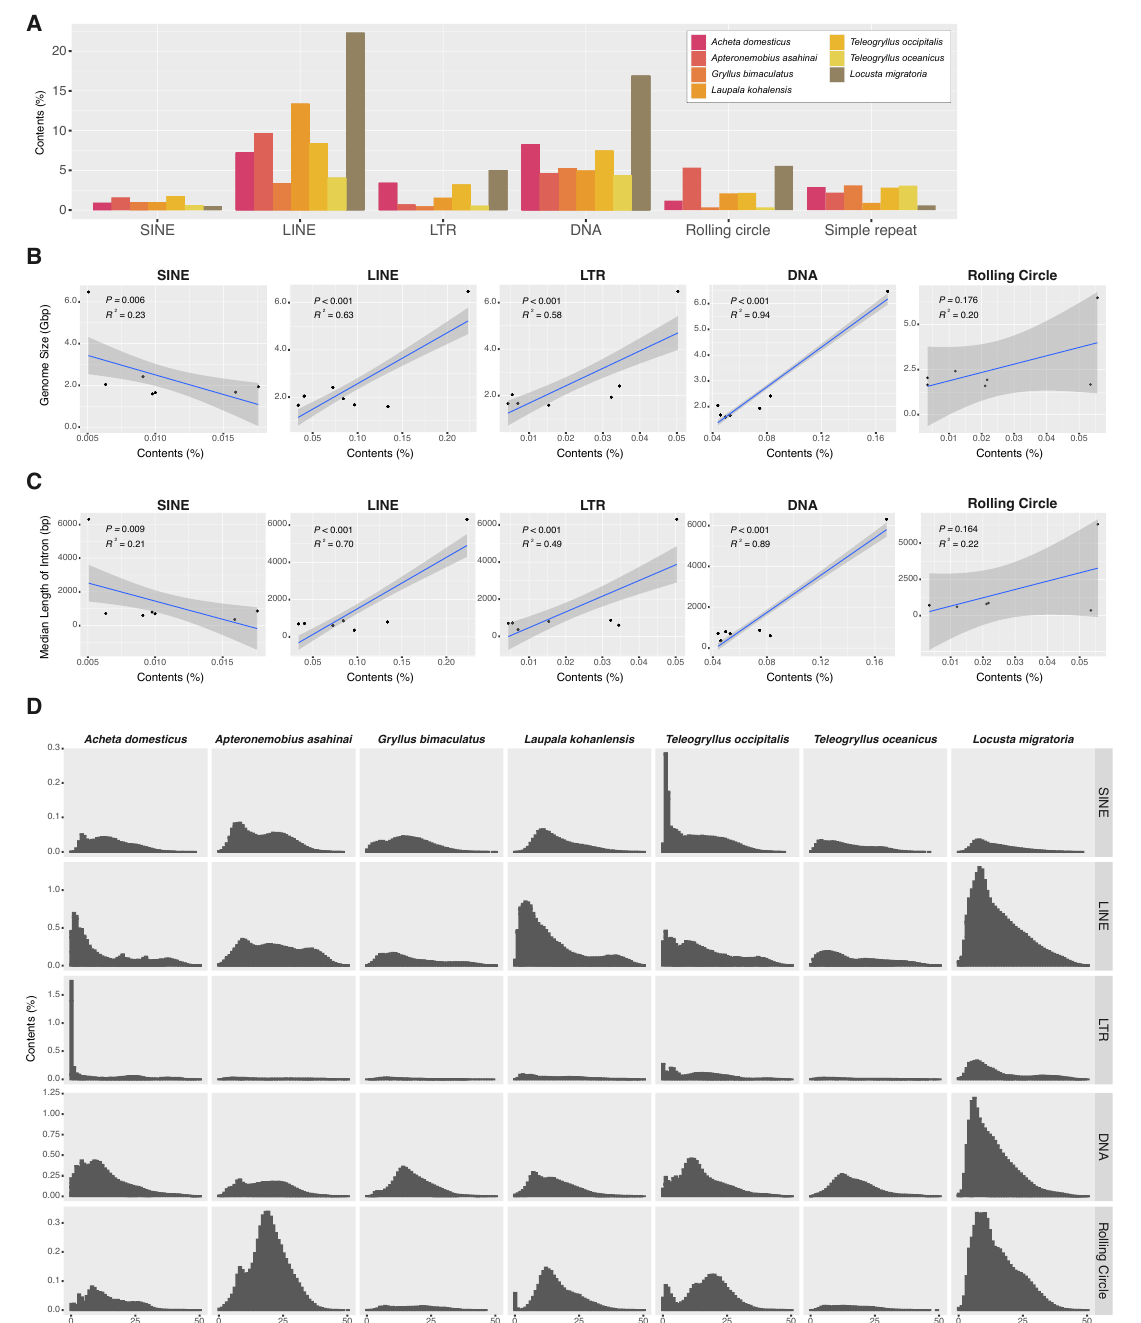
Figure 4. Transposable elements (TEs) in publicly available orthopteran genomes (six crickets, including Acheta domesticus , Apteronemobius asahinai , Gryllus bimaculatus , Laupala kohalensis , Teleogryllus occipitalis , Teleogryllus oceanicus , and one locust, Locusta migratoria ). ( A ) Contents of representative repetitive elements, including TEs, in Orthoptera. The correlation between genome coverages of major TE classes (SINE, LINE, LTR, DNA, and rolling circle) and genome sizes; ( B ) median length of intron; ( C ) Adjusted by Pearson correlation p -values (P) and coefficients (R2); ( D ) Repeat landscape of the major classes of TE classes (SINE, LINE, LTR, DNA, and rolling circle) in the analyzed genomes. The Kimura substitution levels ( x -axis) show sequence divergence, or “TE age”, for the major classes. The classes that are skewed to the left (less sequence divergence) are estimated to have more recently diversified histories than the classes that are skewed to the